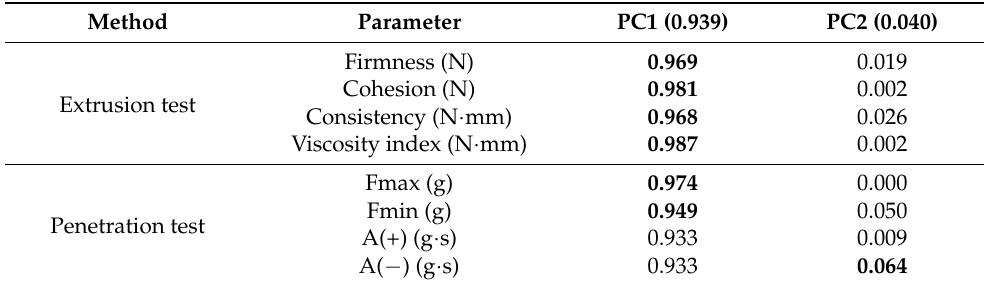
Table 11. Values of cos 2 for each parameter for the two axes of PCA texture test (the significant values are in